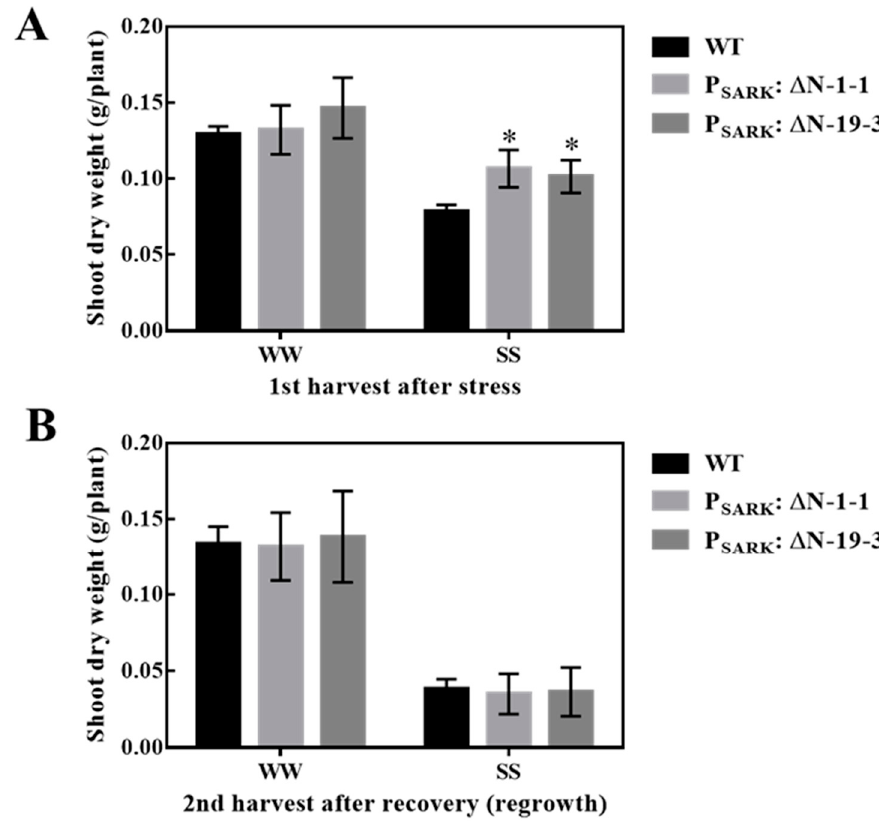
Figure 5. Salt stress tolerance of wild-type (WT) and transgenic Brachypodium sylvaticum plants expressing pSARK: ∆ N. ( A ) Shoot dry weight of WT and two transgenic lines (SARK: ∆ N-1-1 and SARK: ∆ N-19-3) grown under well-watered (WW) and salt stress (SS) conditions during the first harvest. Plants were harvested for the first time at around 45 days old, right after being treated with 100mM NaCl solution for 1 week, and then 200mM NaCl solution for 1 week continuously. ( B ) Shoot dry weight of wild-type (WT) and two transgenic lines during the second harvest. The second harvest was performed at 25 days after the first harvest, during which all the plants were well irrigated with distilled water. Values are means and SE ( n = 12 for SARK: ∆ N and 48 for WT). Asterisks represent significant differences between transgenic lines and WT within a treatment by the Dunnet test ( p < 0.05).